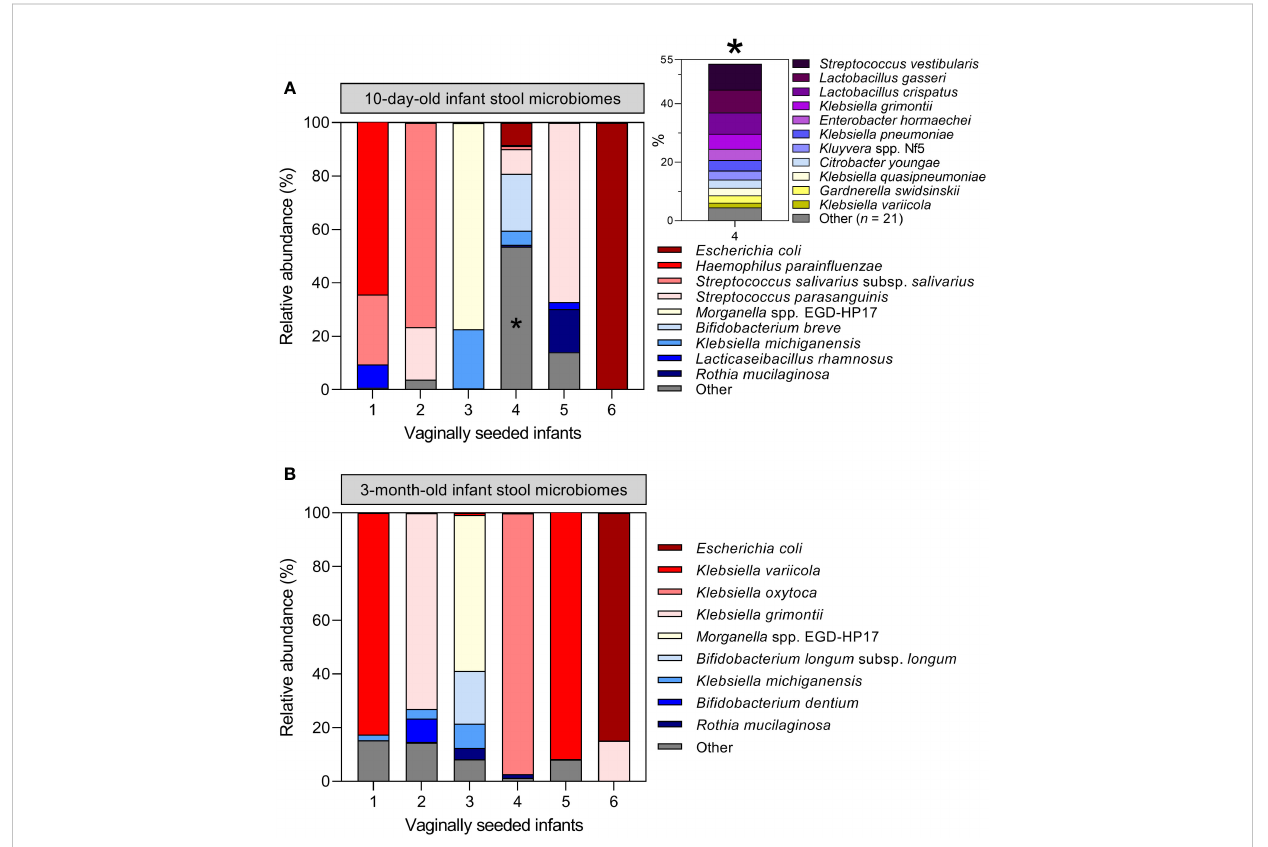
FIGURE 5 Vaginal seeding does not appear to restore the stool microbiome of C/S-delivered infants: Microbiome pro fi les of the six infants in the LEGACY cohort receiving supplementary maternal vaginal microbes by post-partum vaginal seeding at 10 days (A) and 3 months (B) of life. Inset plot in (A) represents 53.6% of the total cpn 60 microbiome pro fi le of infant 4 collapsed into ‘ Other ’ , denoted by an asterisk